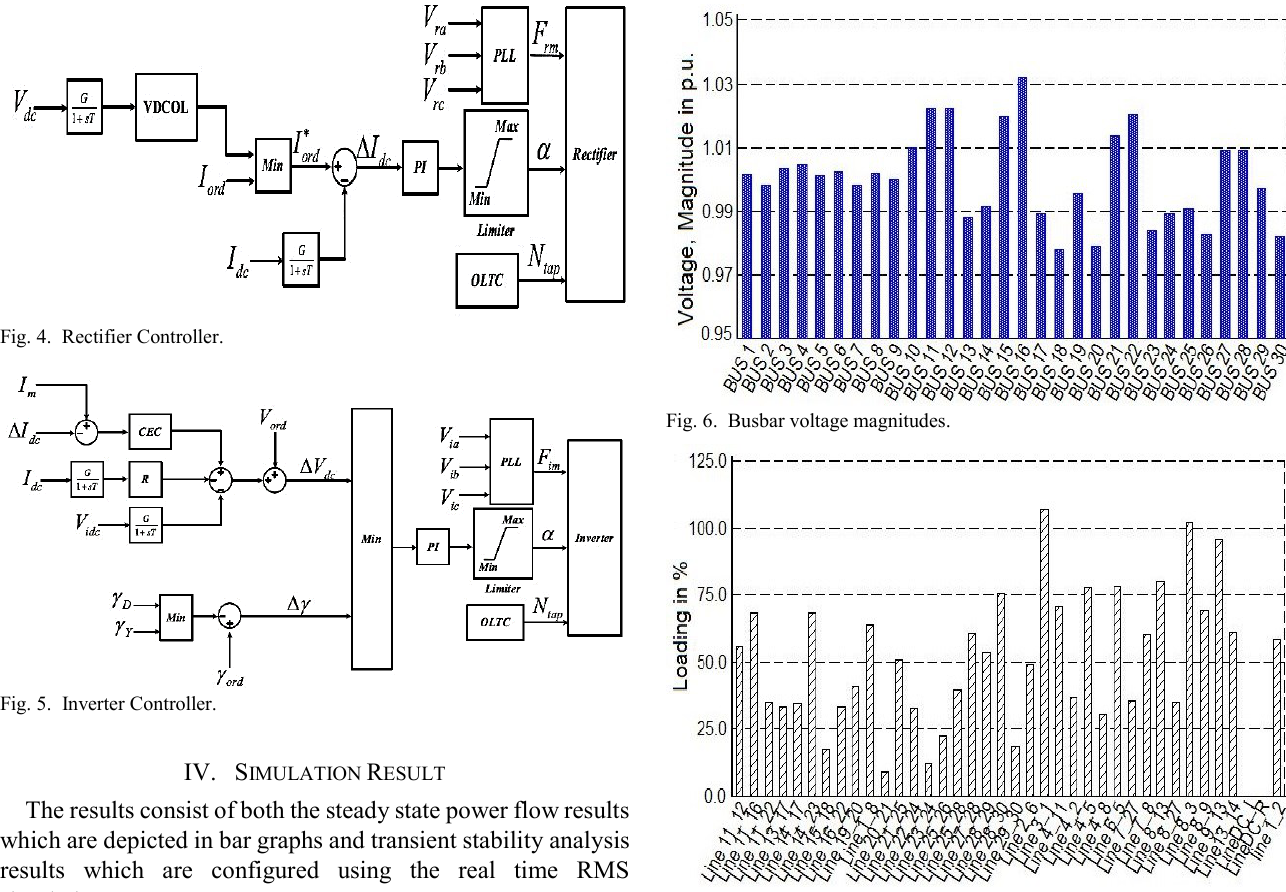
Fig. 7. Line loading (AC Lines only).